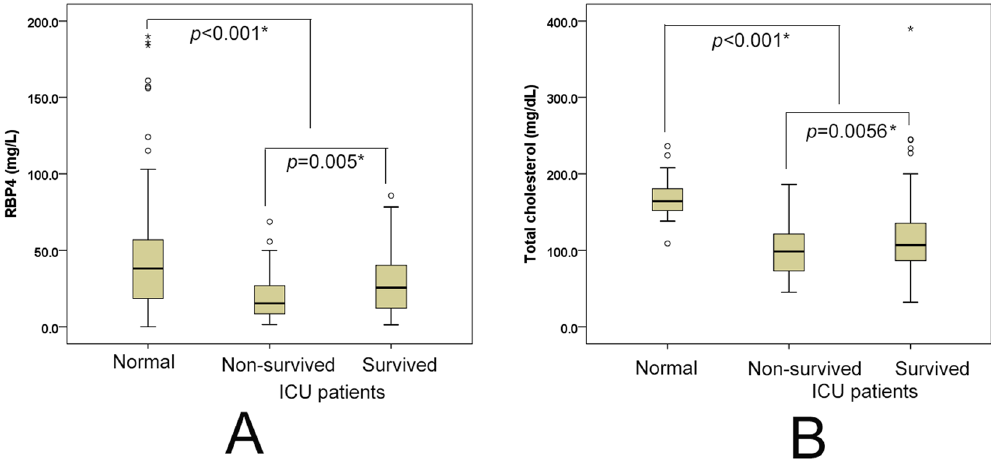
Figure 1. Box-and-whisker plots of the baseline RBP4 ( A ) and TC ( B ) levels in normal controls and liver ICU patients. The outliers are presented as circles or stars. * p <